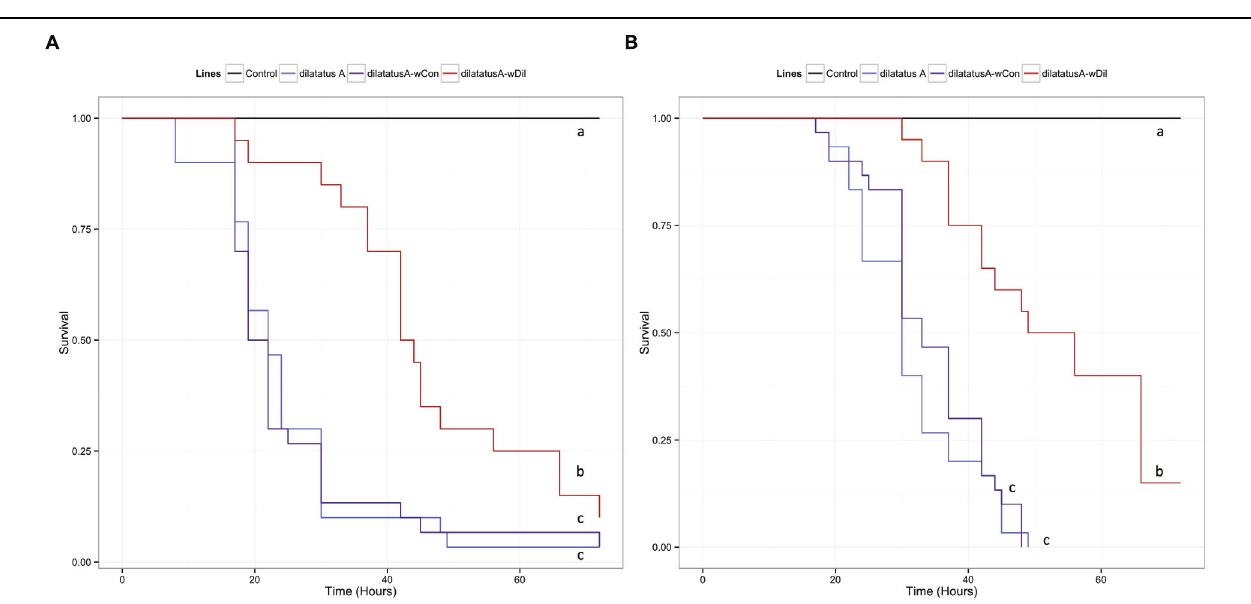
FIGURE 3 | Survival of the different P. dilatatus lines when infected with S. typhimurium . A Cox proportional hazards model was fitted using the survival data of symbiotic ( dilatatus A- w Con, dilatatus A- w Dil) and asymbiotic ( dilatatus A) P. dilatatus lines after being injected with pathogenic bacteria S. typhimurium . Control groups were injected with liquid medium (LB). Results for females (A) and for males (B) are presented separately. Different letters indicate significant differences between the survival curves of different lineages based on log-rank test p <